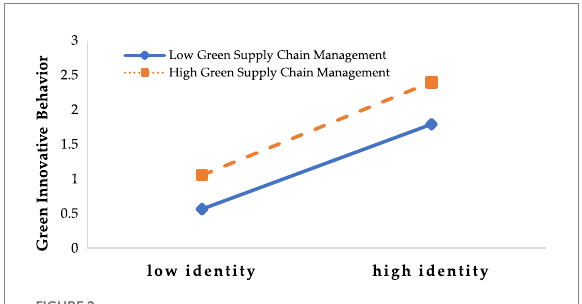
FIGURE 2 The moderating role of green supply chain